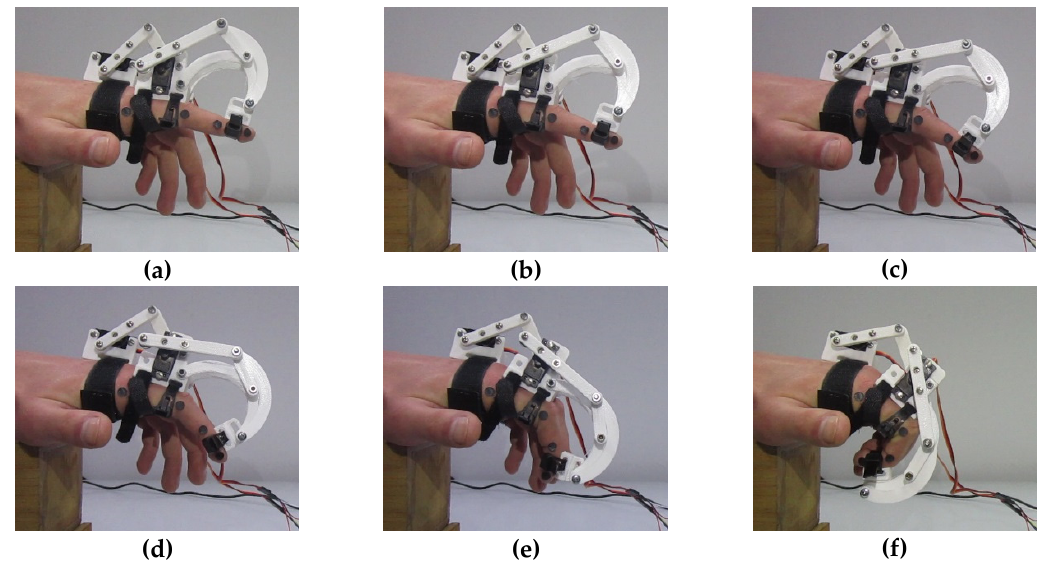
Figure 19. Snapshots of the exoskeleton motion during the test: ( a ) Starting position; ( b ) After 3.2 s; ( c ) After 6.5 s; ( d ) After 9.7 s; ( e ) After 13.0 s; ( f ) Final position.